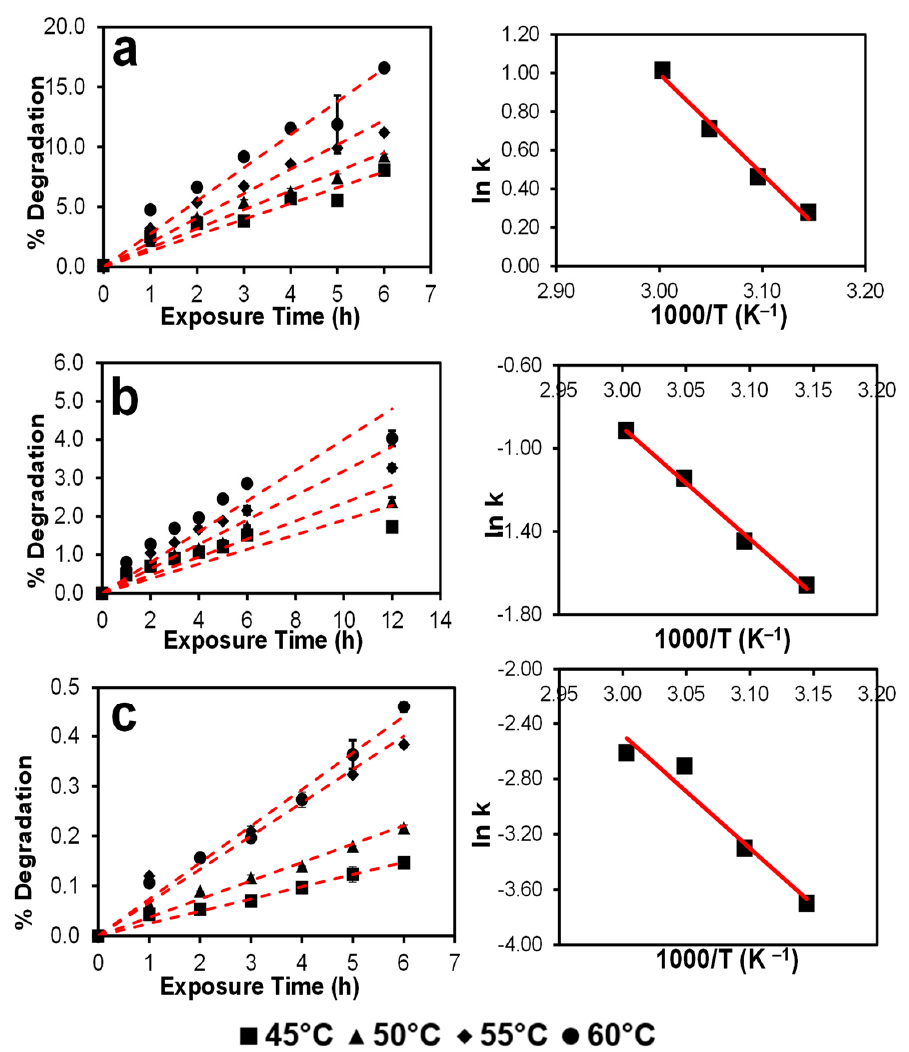
Figure 5. Plots depicting autoxidation kinetics (on the right side) of DPD ( a ), MIF ( b ), and OLA ( c ) in NMP exposed in RapidOxy ® conditions and their respective Arrhenius plots (on the right). The key for left side plots: the symbols represent the average extent of degradation at respective temperatures, and the error bars indicate standard deviation (n = 3 samples), while the red dotted line represents a linear fit. The R 2 was above 0.98 in all the cases. A linear fit was best approximated in the Arrhenius plots on the right (R 2 was above 0.95). Table 3. Experimental autoxidation rates and Arrhenius parameters for the selected drugs in NMP solution